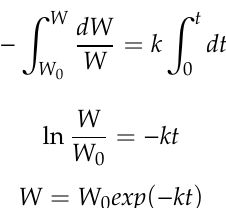
at pH 8, 9, and at pH 8, 9, and 10.